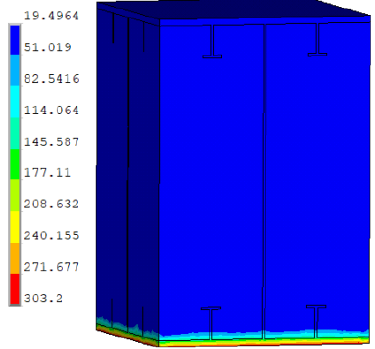
Figure 20. Forward contour plot of the member at 72 s.